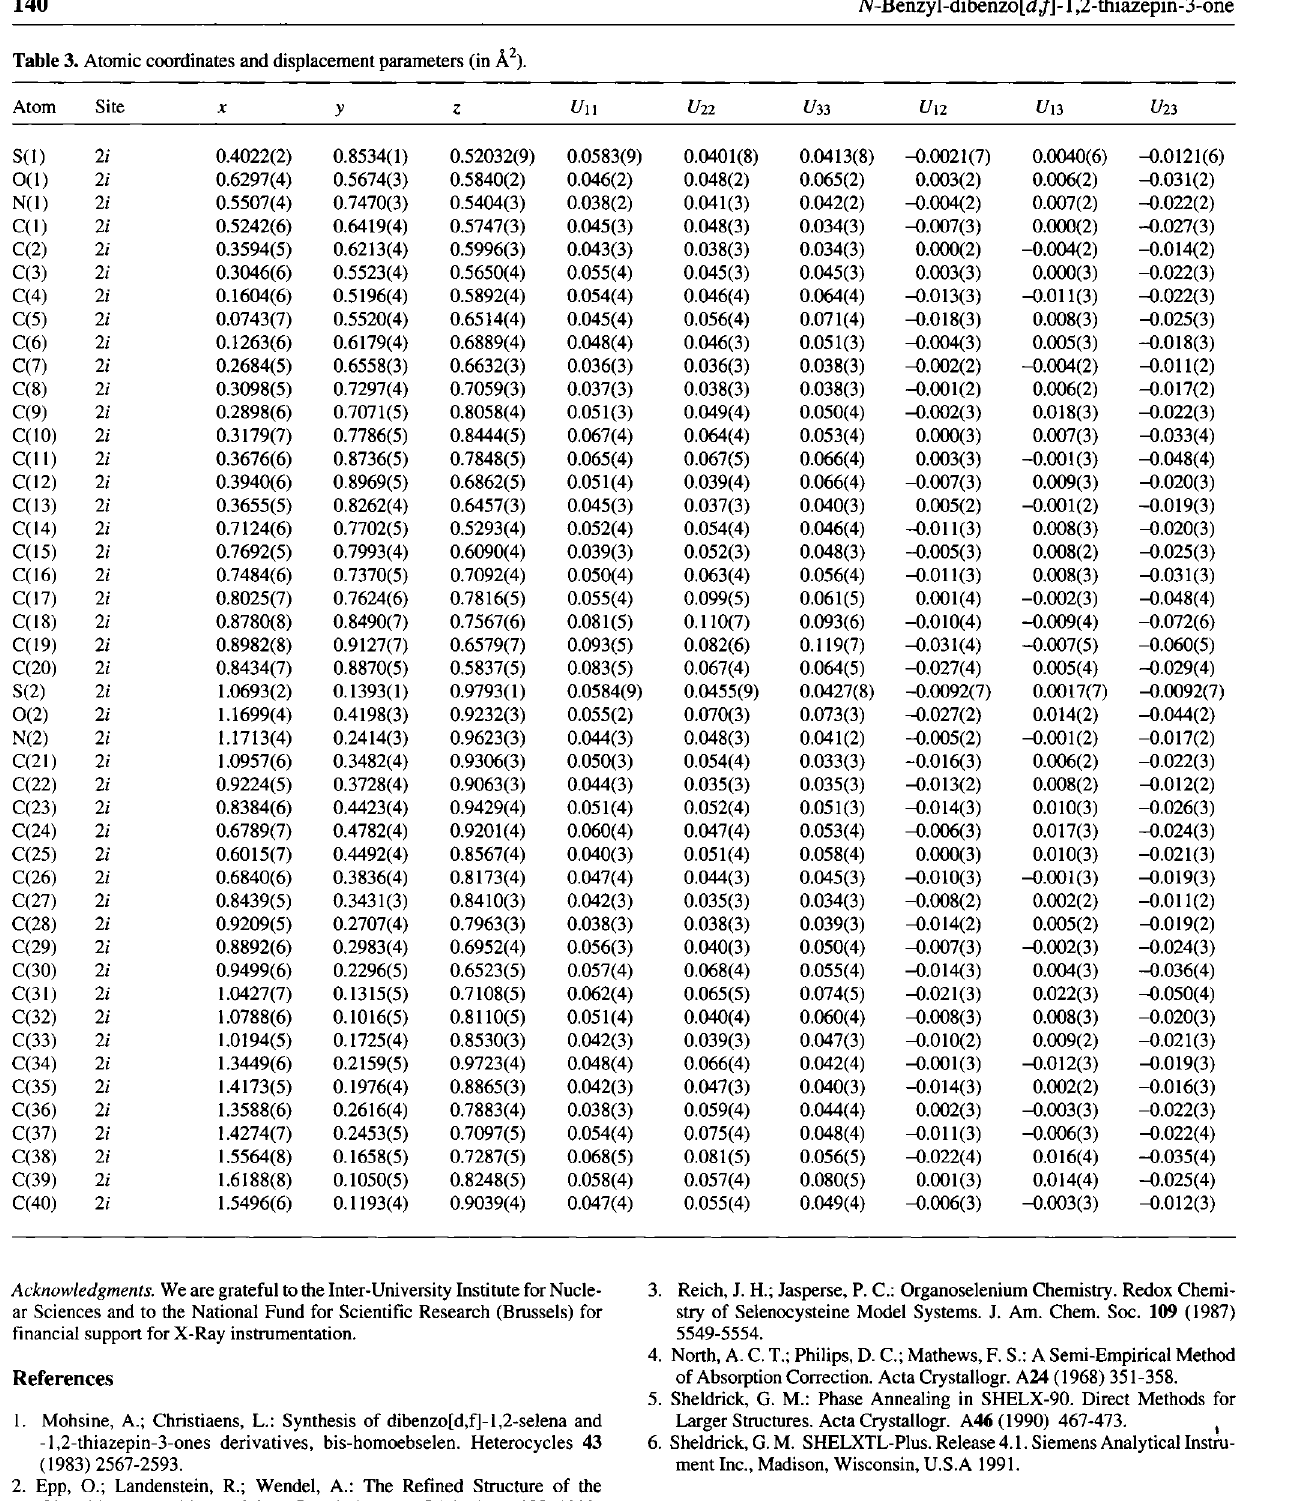
Table 3. Atomic coordinates and displacement parameters (in Â 2